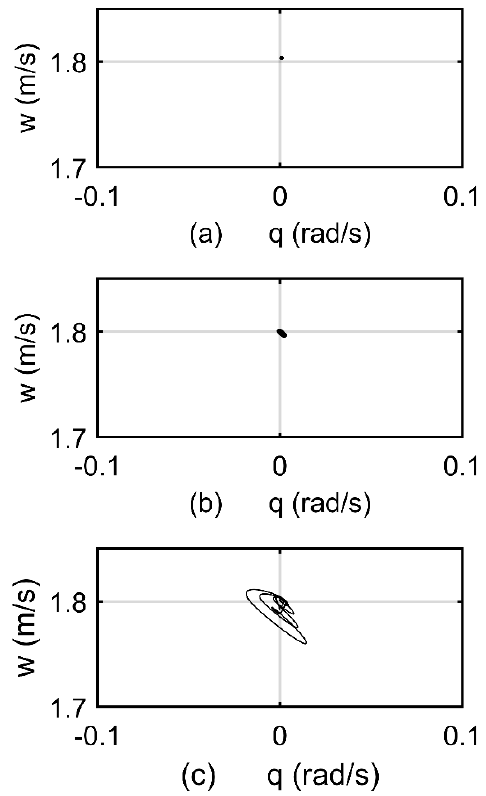
Figure 7. Effect of fractional-order on system stability: ( a ) α = 0.85; ( b ) α = 0.78; ( c ) α = 0.74.